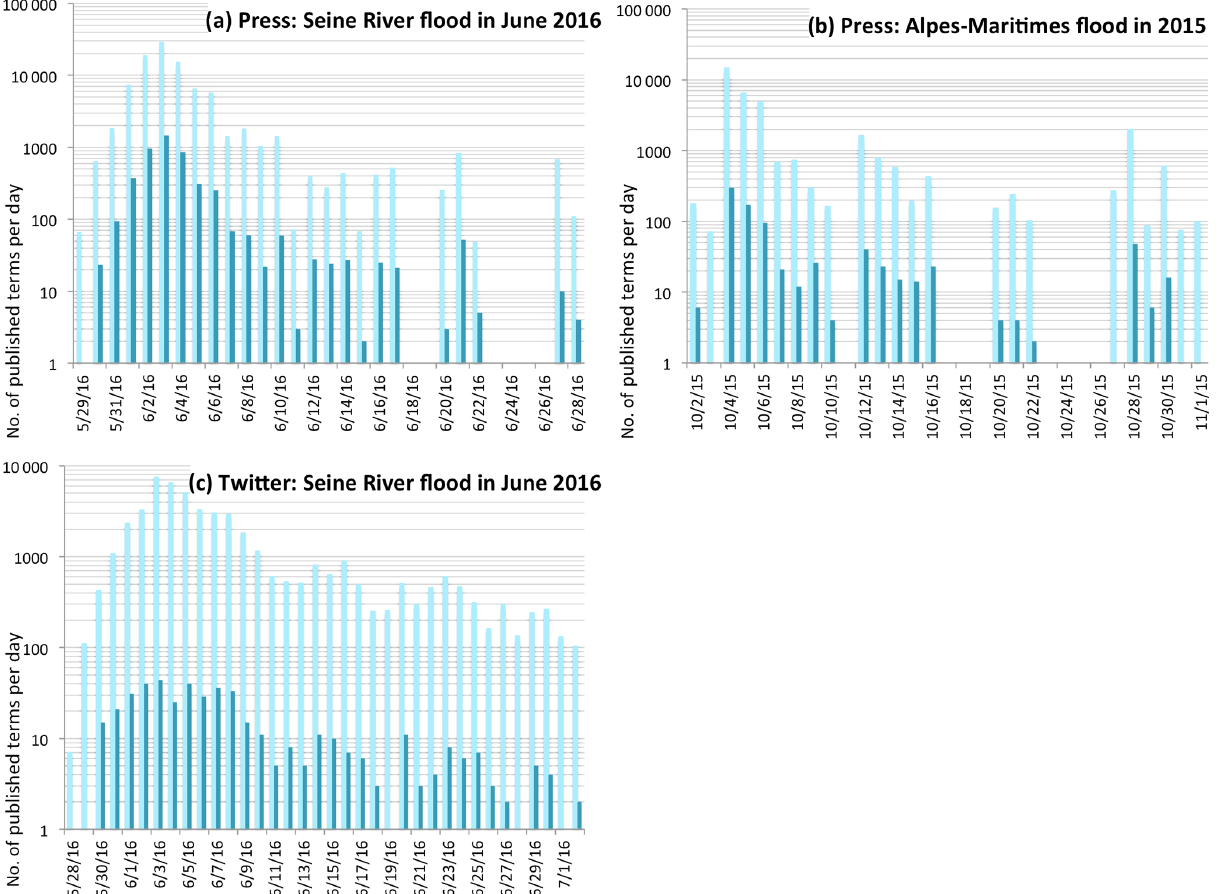
Figure 1. Comparison between the total number of terms per day (light blue) and the number of terms per day referring to flood resilience solutions (dark blue) in a semi-log plot (based on three different